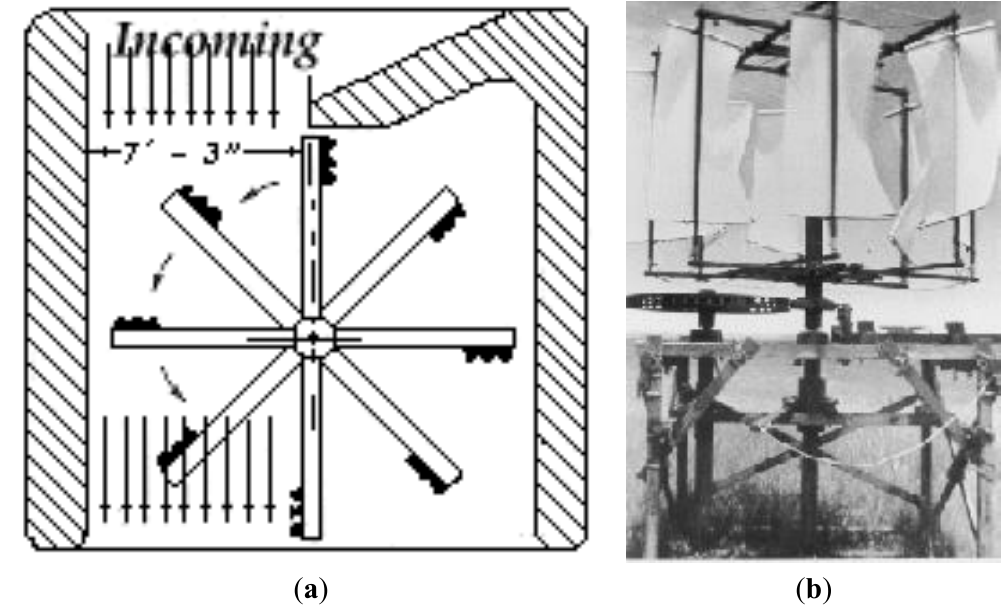
Figure 16. The Persian panemone: ( a ) A design of the Persian panemone; and